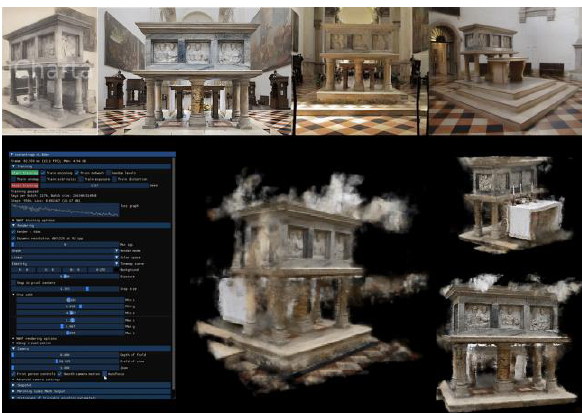
Figure 4 . Volumetric rendering of Altare di San Mathias at the church of S._Giustina in